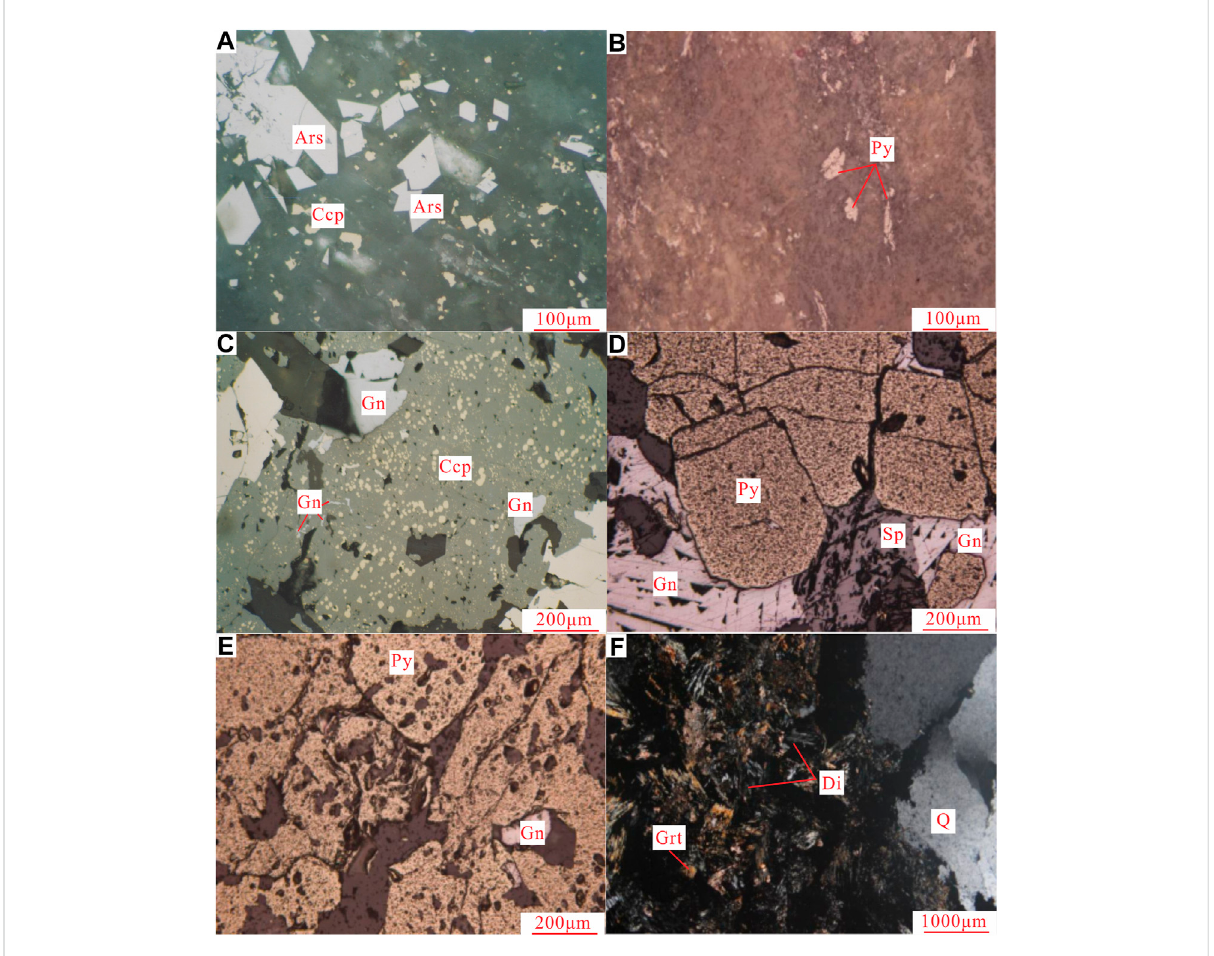
FIGURE 4 Microscopic photographs of the typical wall rock and altered rock in the Hongqigou tectonic zone (re fl ected light or crossed polar). (A) Disseminated texture (re fl ected light); (B) pyrite alteration altered rock; (C) poikilitic texture (re fl ected light); (D) copper – lead – zinc ore; (E) pyrite – galena mineralized rock; (F) ore-bearing skarn. Abbreviations: Ars = arsenopyrite; Ccp = chalcopyrite; Py = pyrite; Gn = galena; Sp = sphalerite; Di = diopside; Grt = garnet; Q =